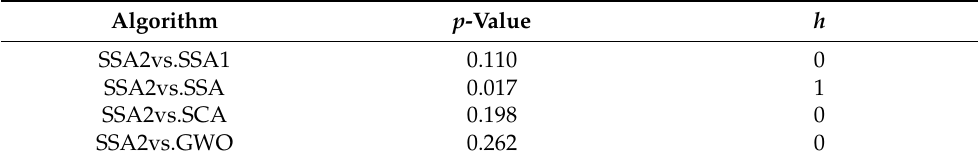
Table 5. Rank sum